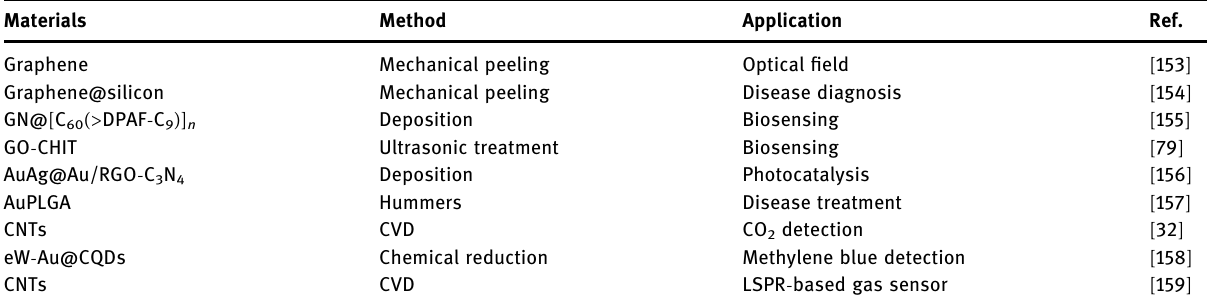
Table 2: Summary of carbon - based P - NMs on synthetic method and application